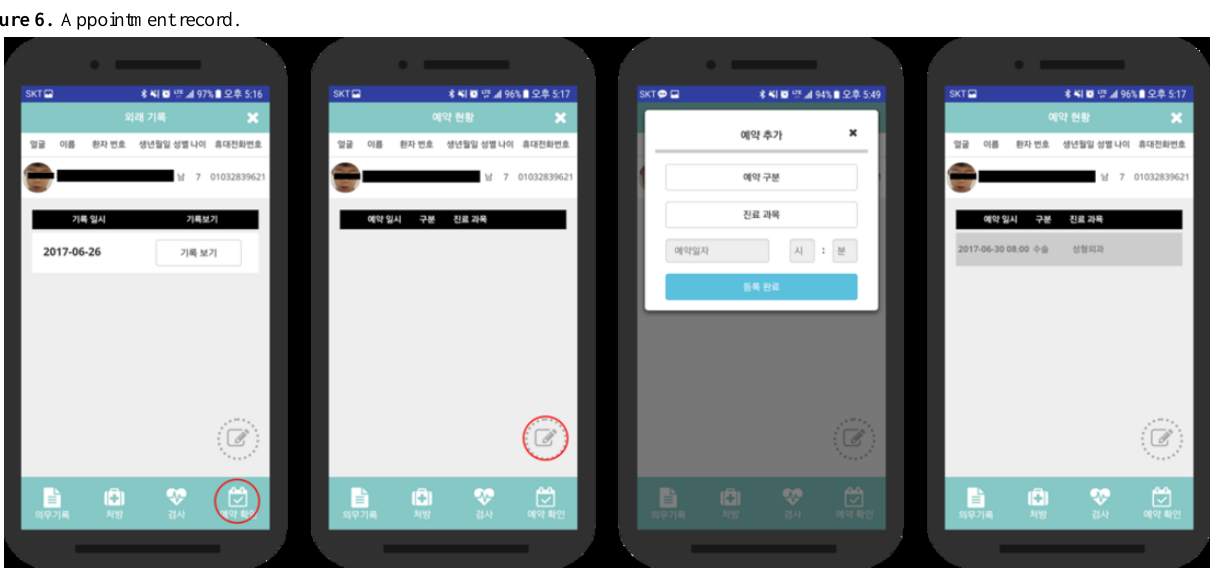
Figure 6. Appointment record.